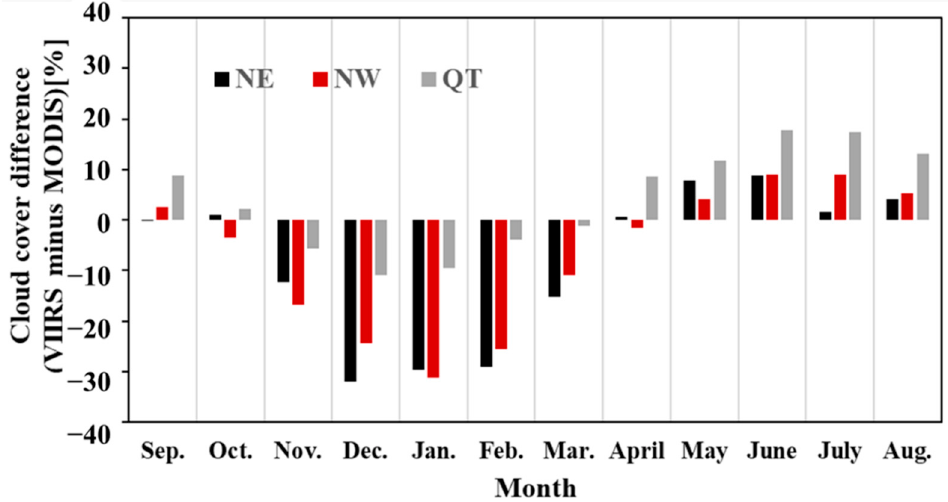
Figure 10. The seasonal fluctuations of cloud cover difference by monthly averages (VIIRS minus MODIS) from September to August next year.